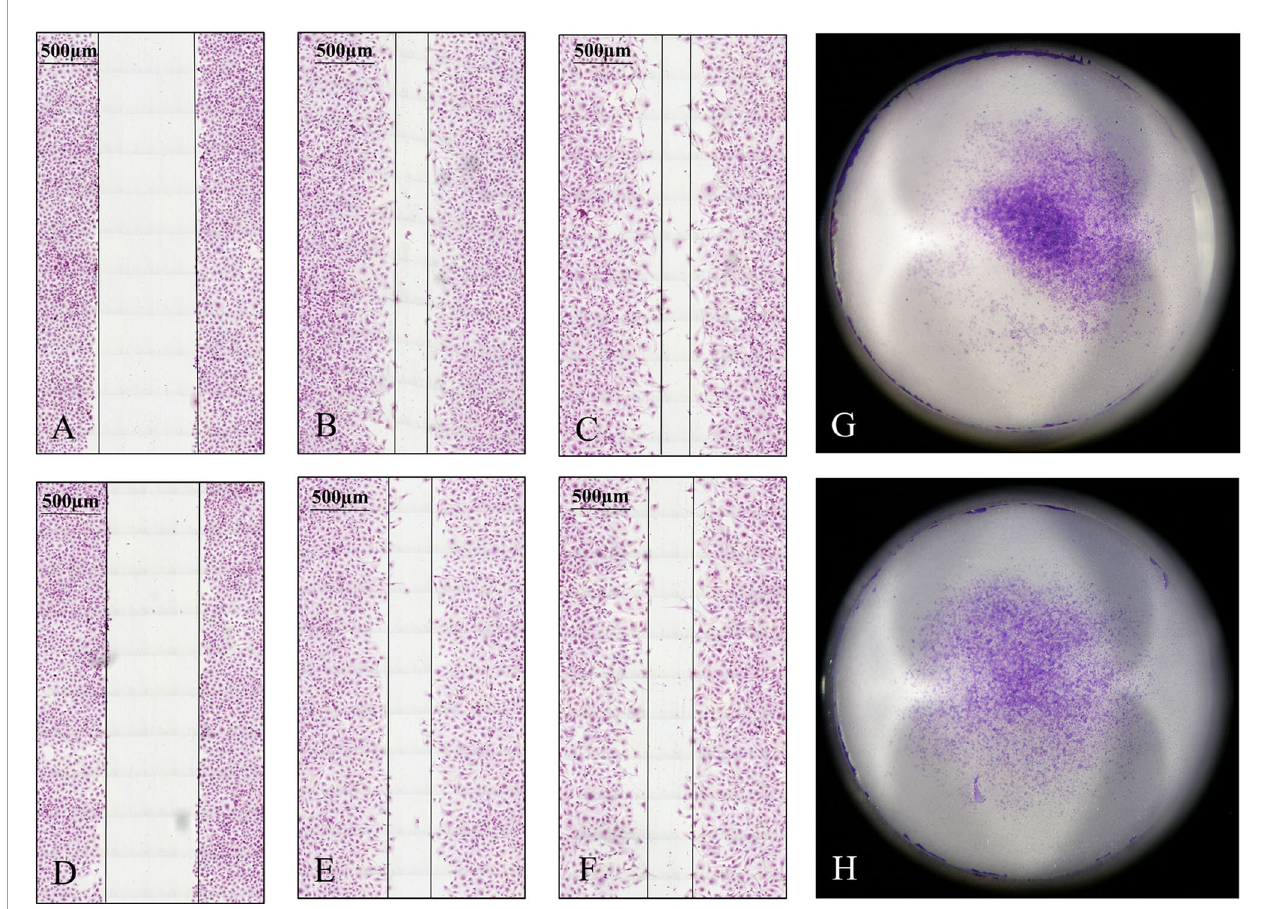
FIGURE 8 | Migration and invasion assays of HLE cells. The tumor cells were observed for 48 h in the migration assay. Silencing of SPOCK1 by siRNA inhibited the migration of the tumor cells. (A – C) Control cells at 0, 24, and 48 h time points. (D – F) SPOCK1 siRNA transfected cells at 0, 24, and 48 h time points. Invasion assay of control (G) and SPOCK1-silenced (H) HLE cells. Silencing inhibited both the migration and invasion of the tumor cells. As control Huh7 cells neither migrate nor invade collagen, no difference between the control and silenced cells could be